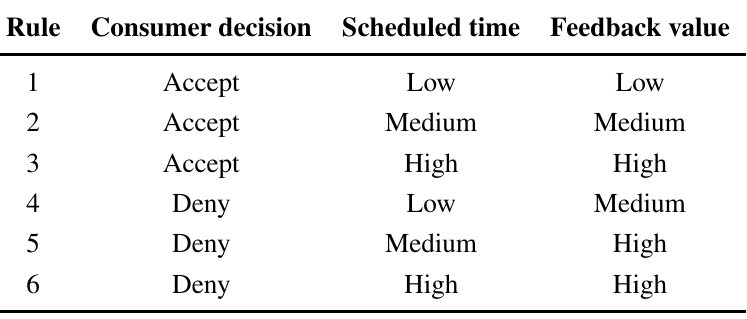
Table 2. Inference rules for consumer